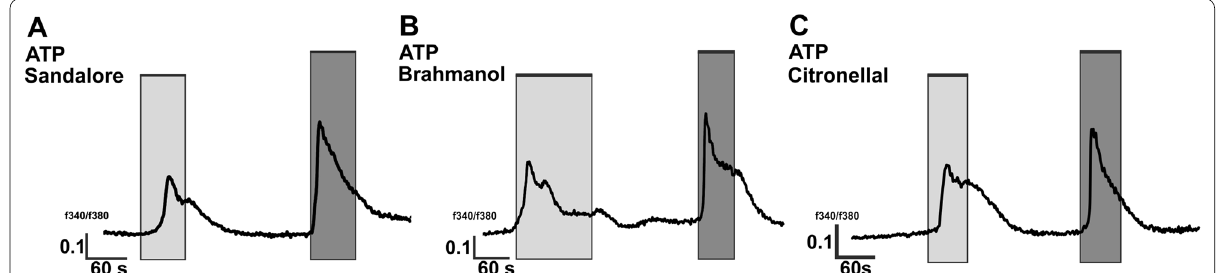
Fig. 1 Stimulation of AM with Sandalore ( A ), Brahmanol ( B ), or Citronellal ( C ) increases intracellular calcium. The application period of the odorant (300 µM) is marked in light grey ATP (100 µM) was applied as a vitality control (dark